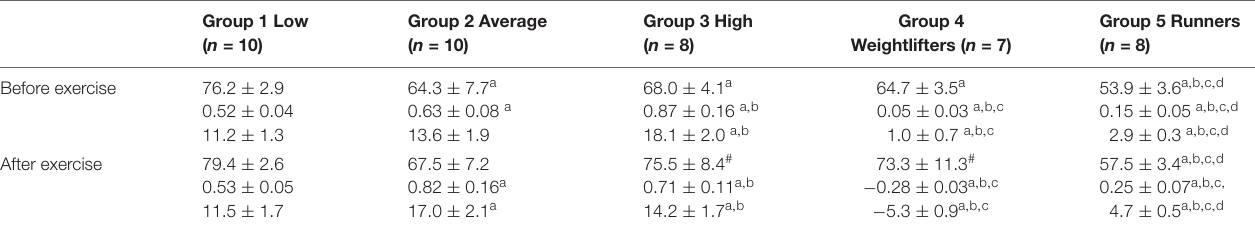
TABLE 3 | Resting heart rate (top, bpm), and absolute (middle, mm) and relative (bottom,%) changes in the diameter of the brachial artery after occlusion test.